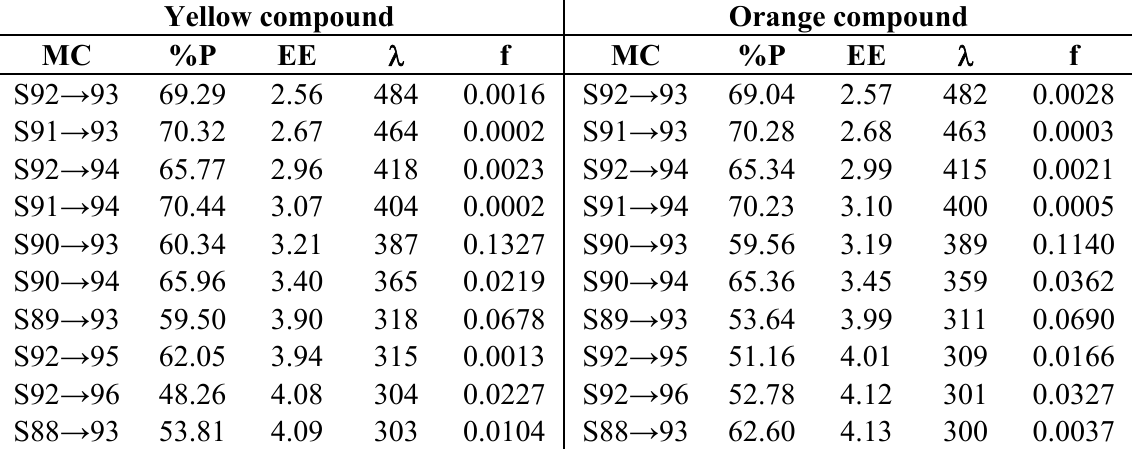
Table 1. TDDFT exited states spectra performed in MeNC environment. Main contribution (MC) to each exited state with the HOMO corresponding to the 92 orbital. transition occurs and oscillator strengths (f) computed for both yellow and orange